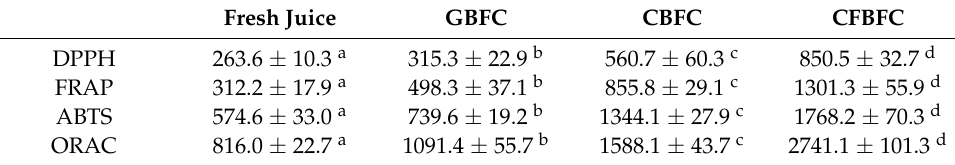
Table 2. Antioxidant activity of fresh juice and cryoconcentrated